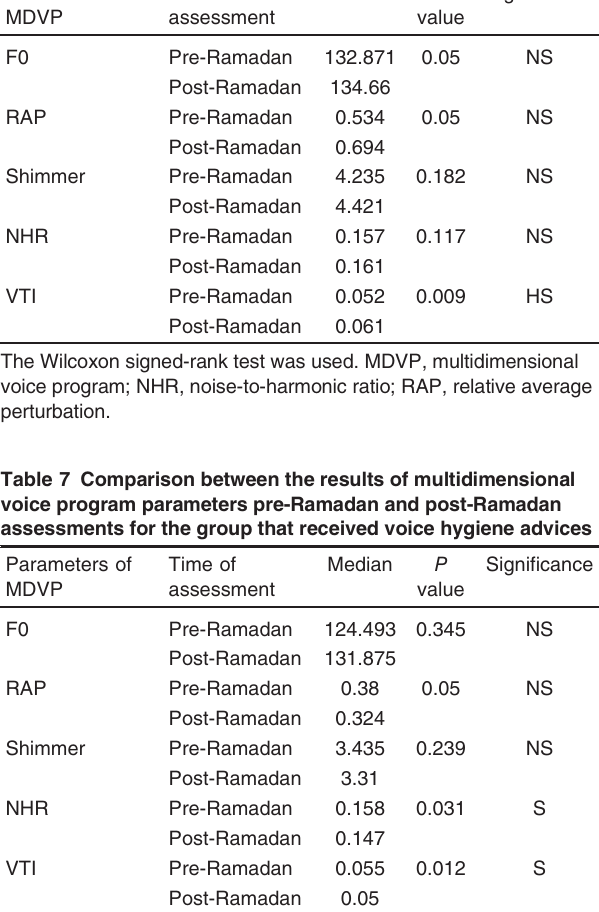
Table 6 Comparison between the results of multidimensional voice program parameters pre-Ramadan and post-Ramadan assessments for the control group Parameters of MDVP